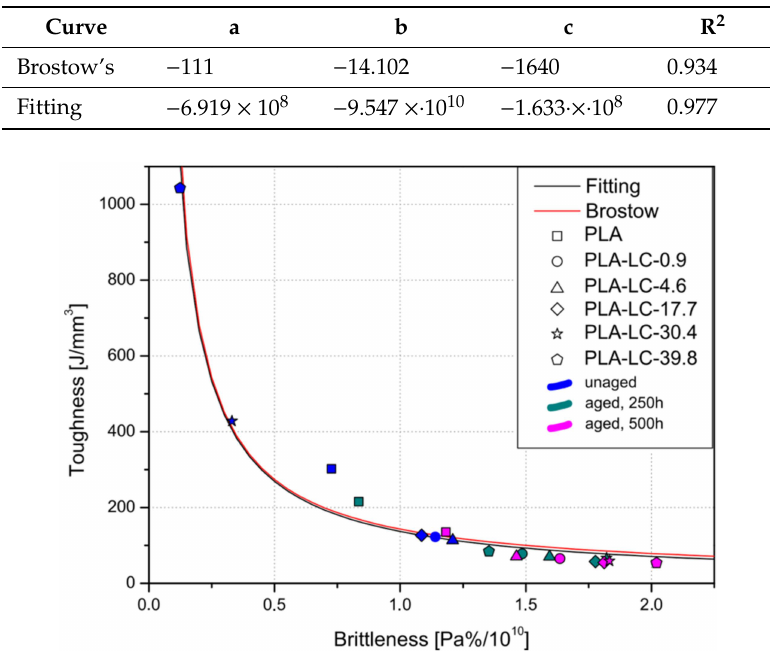
Figure 8. Experimental points and theoretical curves representing the correlation between the toughness and brittleness of the